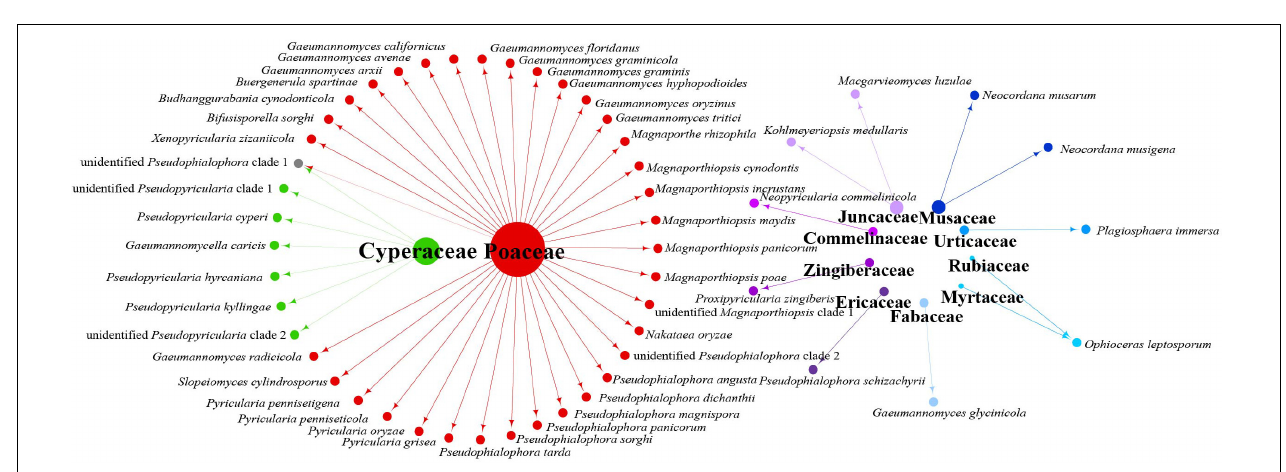
FIGURE 4 | Network of parasitic fungal Magnaporthales species from shoots and roots using meta-analysis.